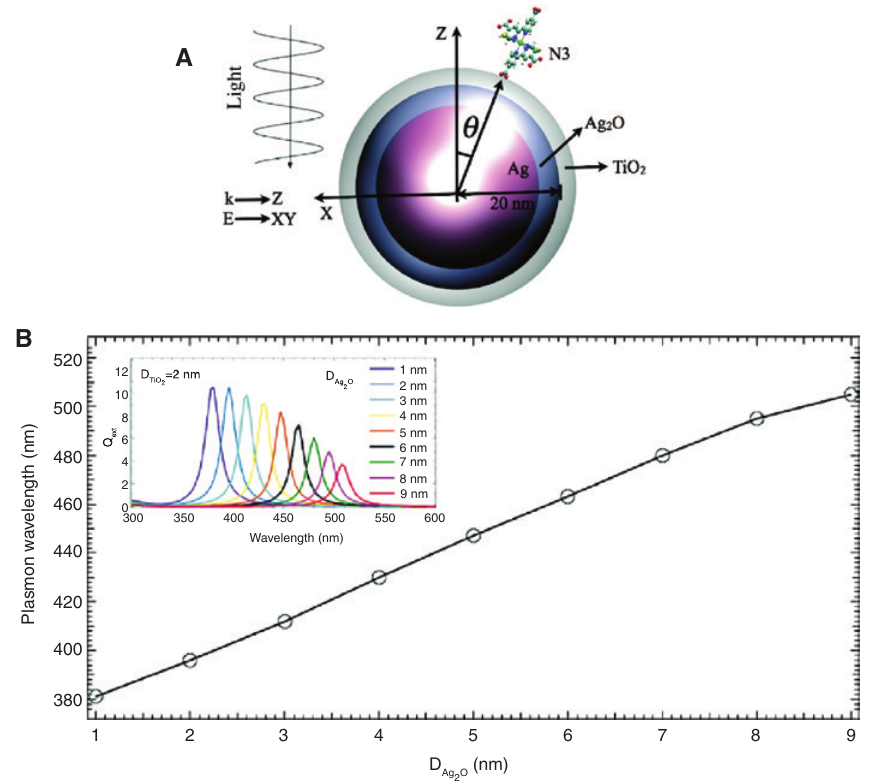
/Ag composite DSSC, where the incident light propagates along axis Z , and the polarization direction Figure 9: (A) Structure of the N3/TiO 2 is uniformly distributed in the XY plane. The relative location of N3 dye on the TiO surface is indicated by the polar angle, θ and (B) depend- 2 ence of plasmon wavelength on the thickness of Ag O (D ) when the thickness of TiO (D ) is fixed at 2.0 nm, and the radius of the oxidized 2 Ag 2 O 2 TiO 2 + D silver sphere (R ) is fixed at 20.0 nm. The results from FDTD simulation and Mie theory are presented in red and black lines, respec- Ag Ag 2 O tively. In addition, the extinction profile as a function of D , which is calculated from Mie theory, is illustrated in the inset. Reprinted with Ag 2 O permission from [70]. Copyright 2004 American Chemical